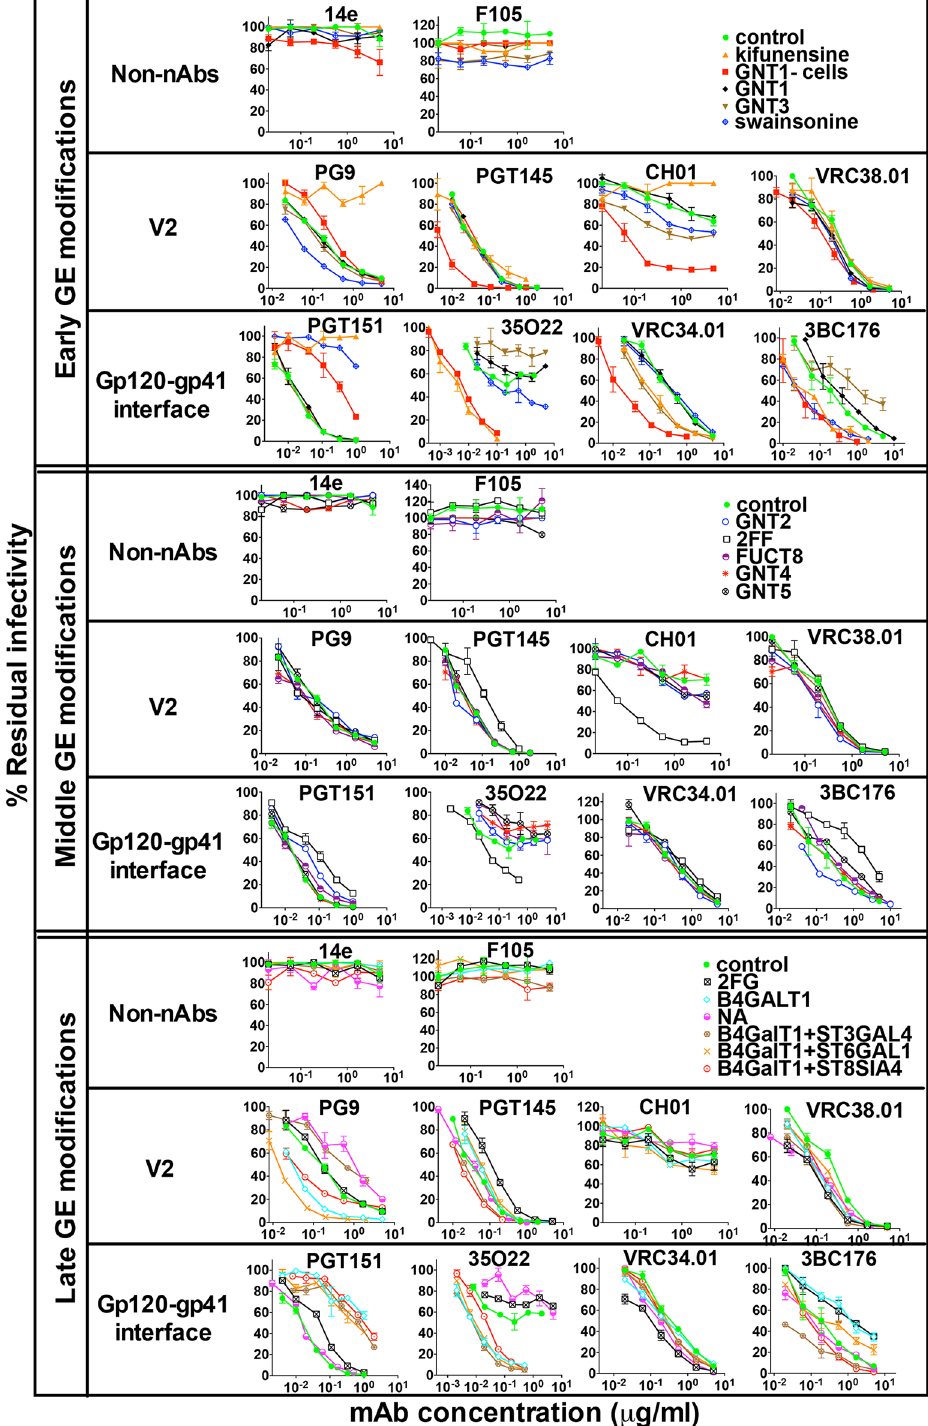
Fig 3. Effects of GE on JR-FL sensitivity to V2 apex and gp120-gp41 interface bnAbs. Non-nAbs 14e and F105 were used to monitor any overt impacts of GE on the tier 2 phenotype. For mAb 3BC176, a JR-FL N88A mutant was used. Results are representative of at least two repeats performed in duplicate. Error bars show standard deviations (SD). IC50s are shown in Fig 2A. GNT3 modification was included in this early set of GE modifications instead of GNT2, as it promotes smaller, hybrid